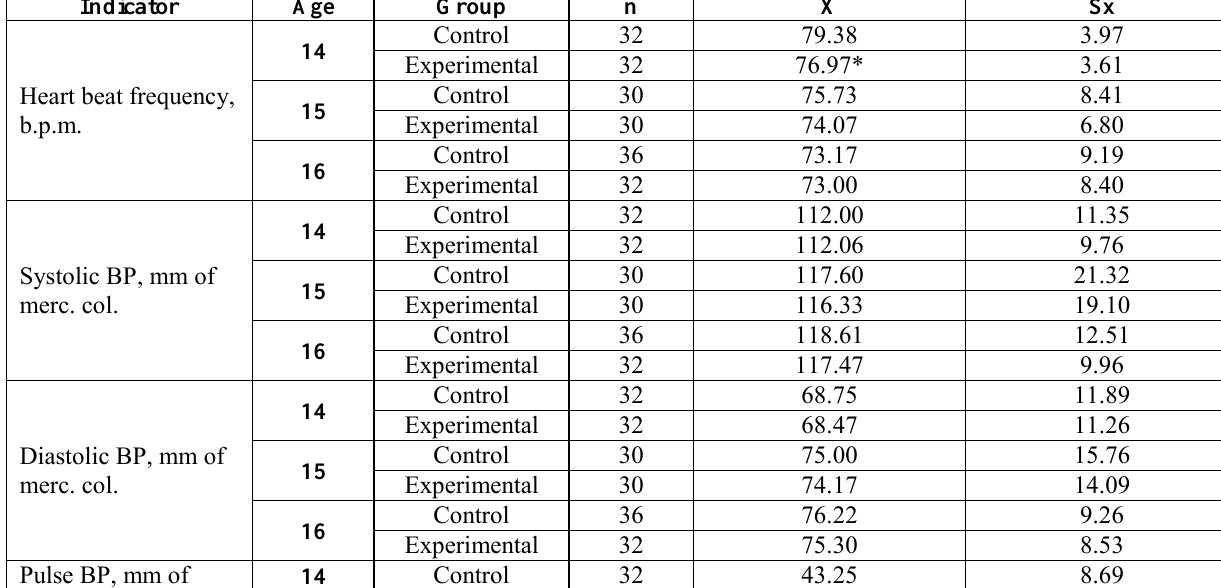
Indicators of cardio-respiratory systems in rest of 14-16 years old boys of experimental and control groups after application of experimental